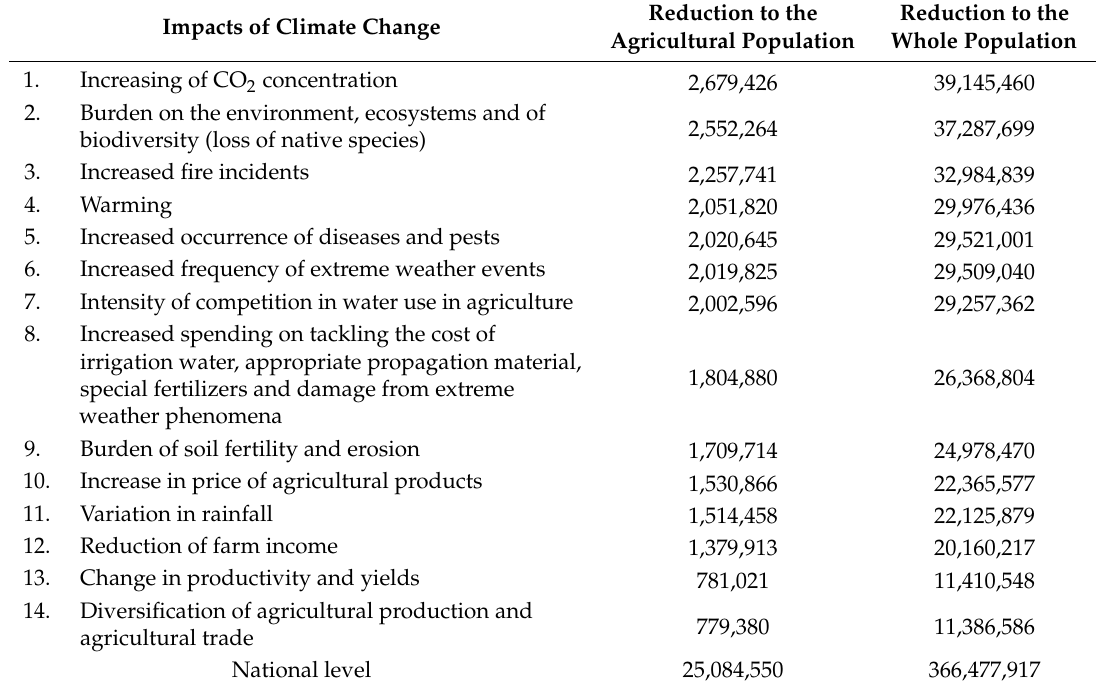
Table 2. Reduction of the estimations of climate change impacts